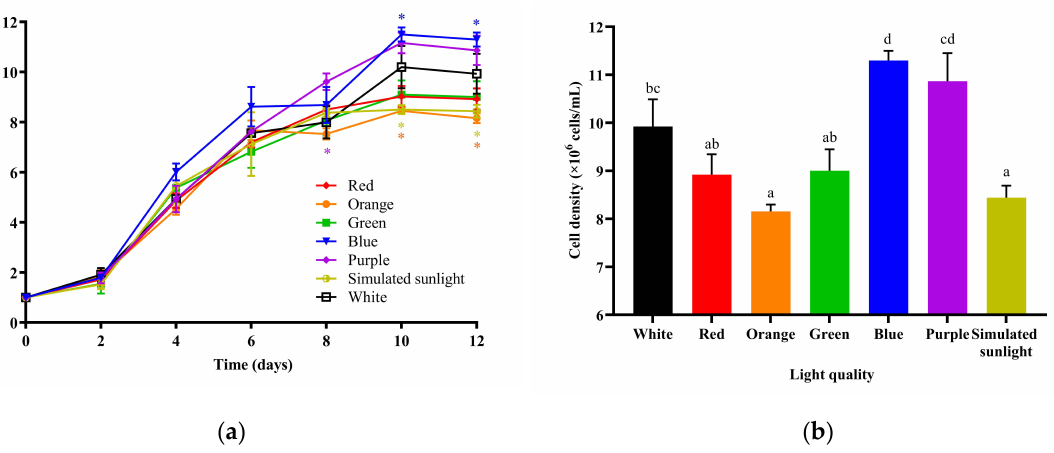
Figure 2. Growth curves of I. zhanjiangensis ( A ) and algae densities on the 12th day under seven LED light conditions ( B ). * indicates that the algae density under the corresponding light was significantly different from under white light ( p < 0.05); lowercase letters indicate significant difference in algae density ( p < 0.05).